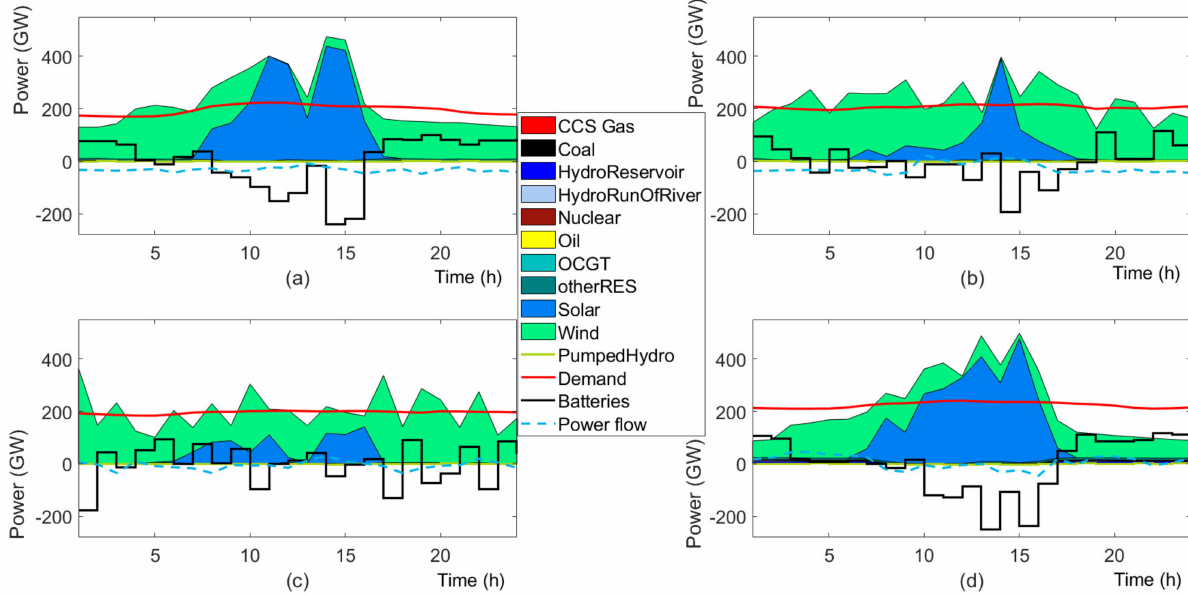
Figure 19. Generation mix in region WR according to scenario node 8 with the availability of storage, in four typical days. Figure ( a ) reports a typical day within the period January–March, ( b ) a typical day within April–June, ( c ) a typical day within July–September, and ( d ) a typical day within